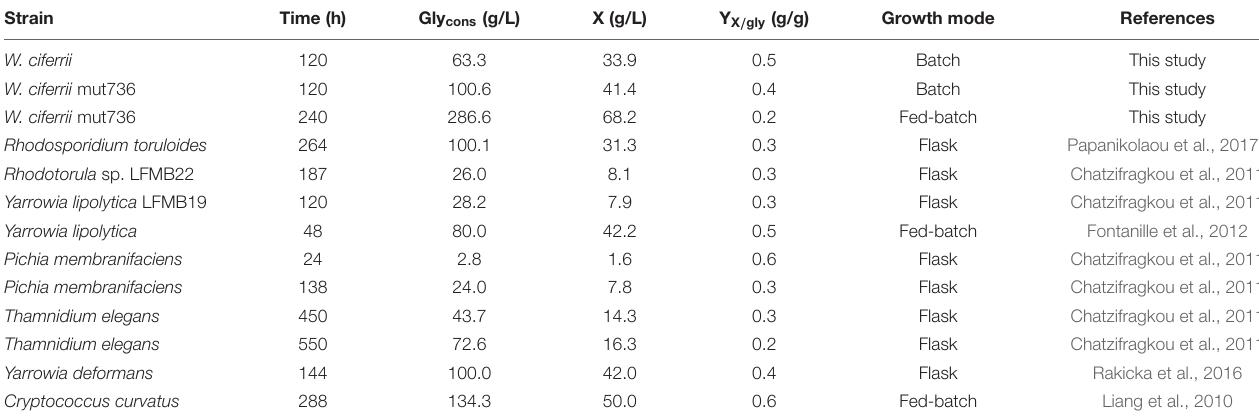
TABLE 2 | Comparison of growth parameters of selected yeasts grown on glycerol. Strain Time (h) Gly cons (g/L) X (g/L) Y X / gly